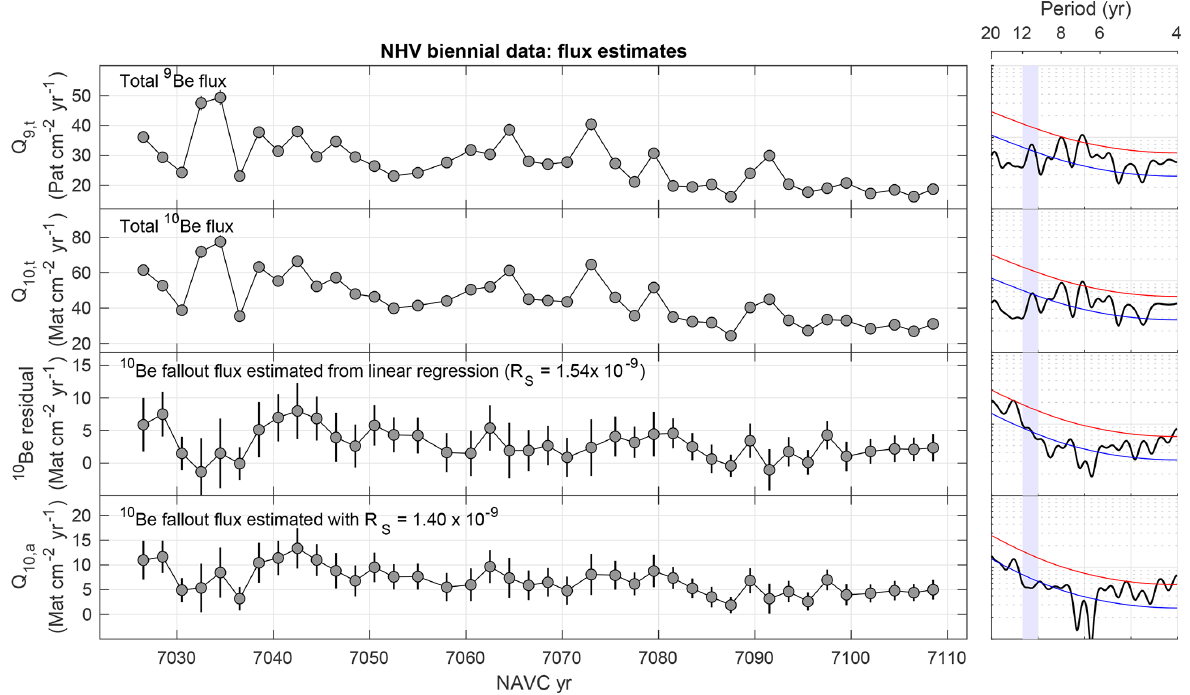
Figure 14. Be flux estimates for an 80-year biennial record at NHV. Total fluxes are calculated using the grain size–sediment density relationship shown in Fig. 3. 10 Be fallout fluxes are estimated from Eq. (1) using two different values of R S : the value inferred from the linear regression in Fig. 13 and a second value chosen to yield higher apparent fallout fluxes and highlight the fact that apparent time variations in the flux are not strongly dependent on the choice of R S . Error bars reflect the propagation of uncertainty on Be isotope concentrations but not on mass accumulation rates, so it may be underestimated. Plot elements for MTM spectra are the same as in Fig.